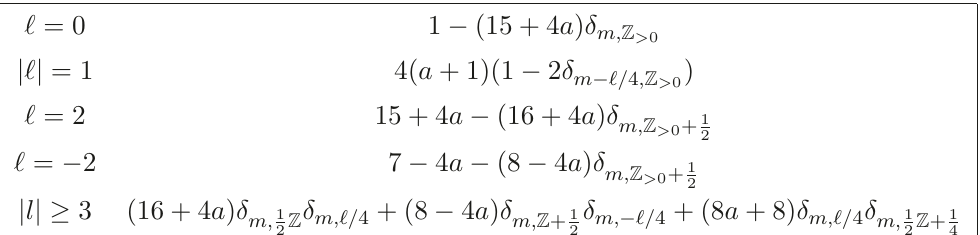
Table 4 . Values of d ∗ ( n, m, l ) appearing in the elliptic genus of the symmetric orbifold of n> 0 ( T 2 / Z 2 ) 2 . P